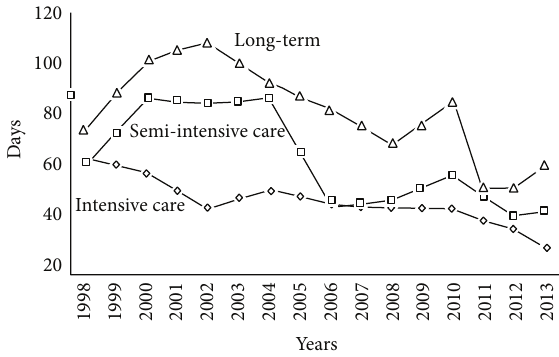
Figure 2: Average time (days) spent in the ICU or neurology/ neurosurgery units of local hospitals before admission and in the Institute S. Anna-RAN dedicated units after